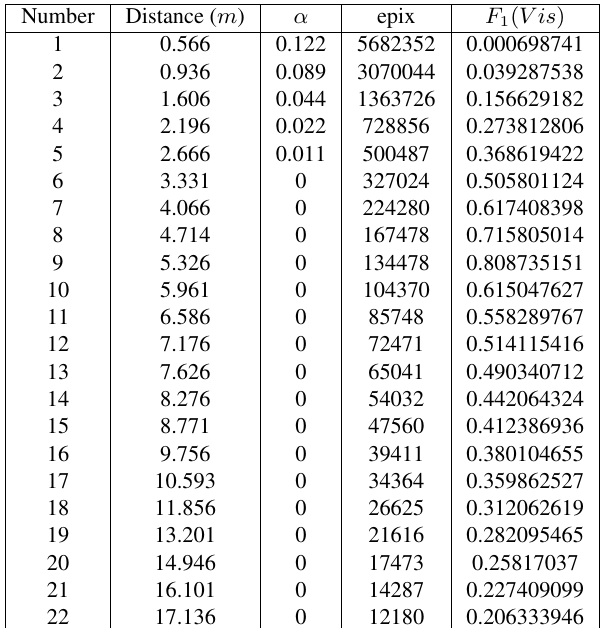
Table 3. Experiment Results of F C